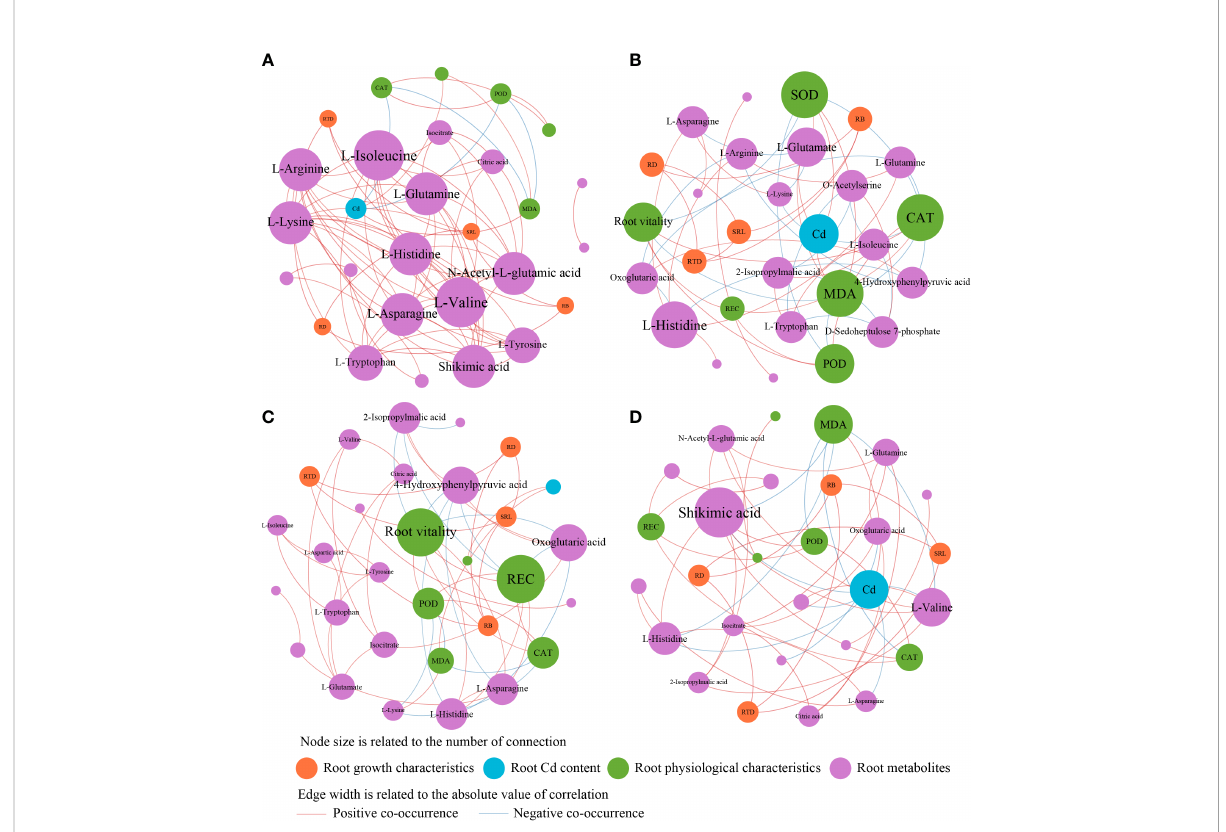
FIGURE 7 Heatmap of the correlation between metabolites and environmental factors in each treatment. REC, electrolyte leakage rate; MDA, malondialdehyde; POD, peroxidase; SOD, superoxide dismutasee; CAT, catalas; RTD, root tissue mass density; RB, root biomass; RD, speci fi c root length density; SRL, speci fi c root length; Cd, root Cd